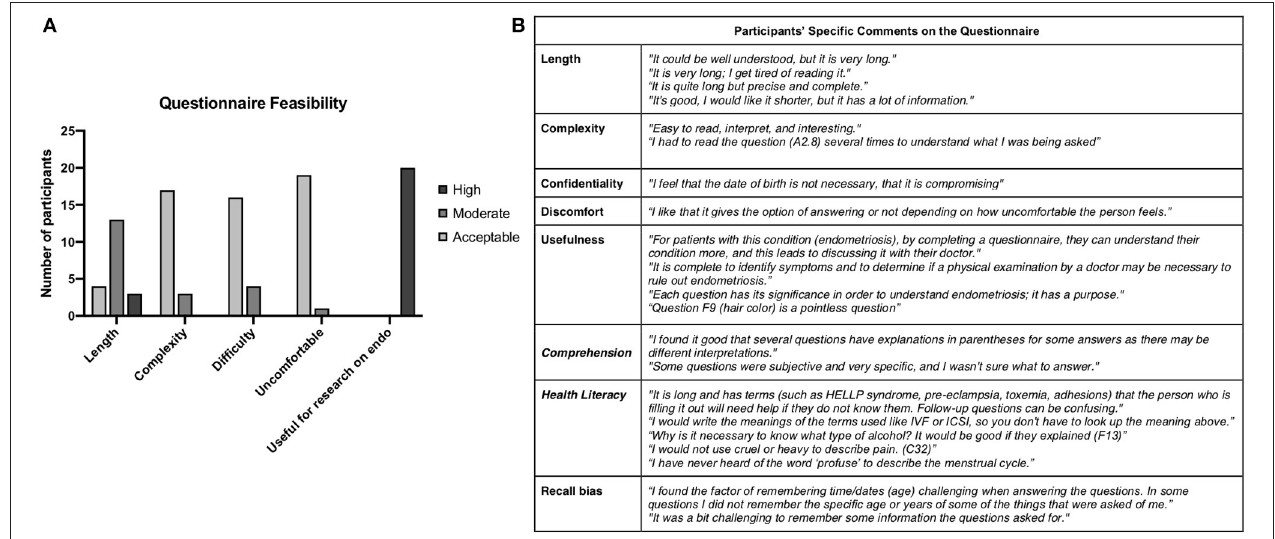
FIGURE 1 | Validation of the Spanish EPhect clinical minimal questionnaire. (A) Quantitative assessment of feasibility. (B) Specific comments made by questionnaire